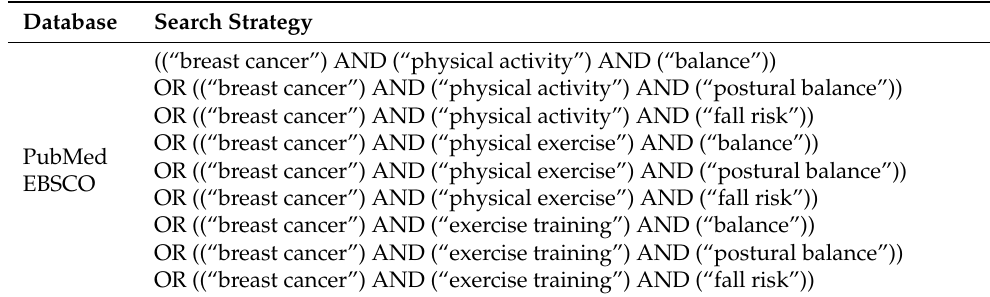
Table 1. Summary of search strategies in both research databases used (PubMed and